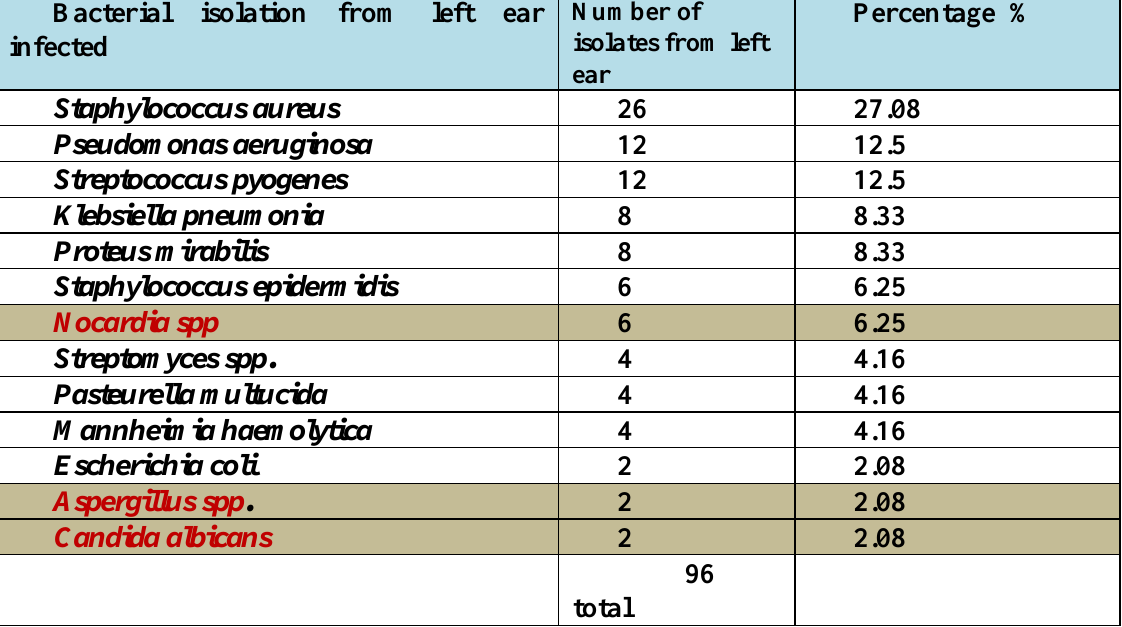
Table 2: Numbers of bacteria and fungus species isolates from infected Left ear in